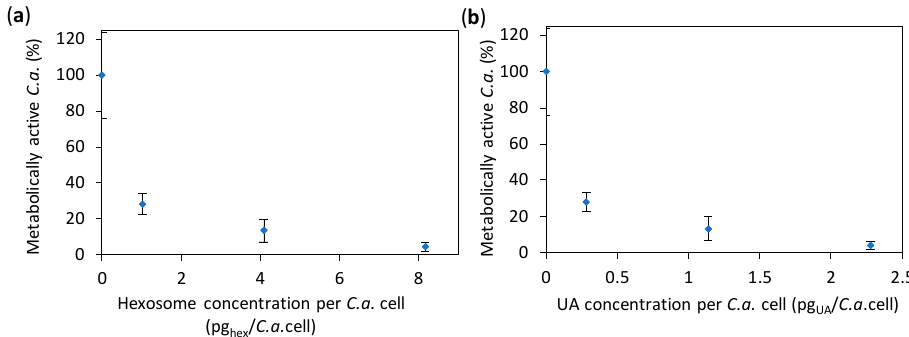
Figure 4. The percentages of metabolically active Candida albicans ( C.a. ) cells treated with the different hexosome concentrations were normalized with the number of metabolically active C.a. cells treated with media without hexosomes (control). The results are given as a function of: ( a ) the concentration of hexosomes per C.a. cell; and ( b ) the concentration of undecylenic acid (UA) per C.a. cell; all values are given as the mean ± standard deviation.